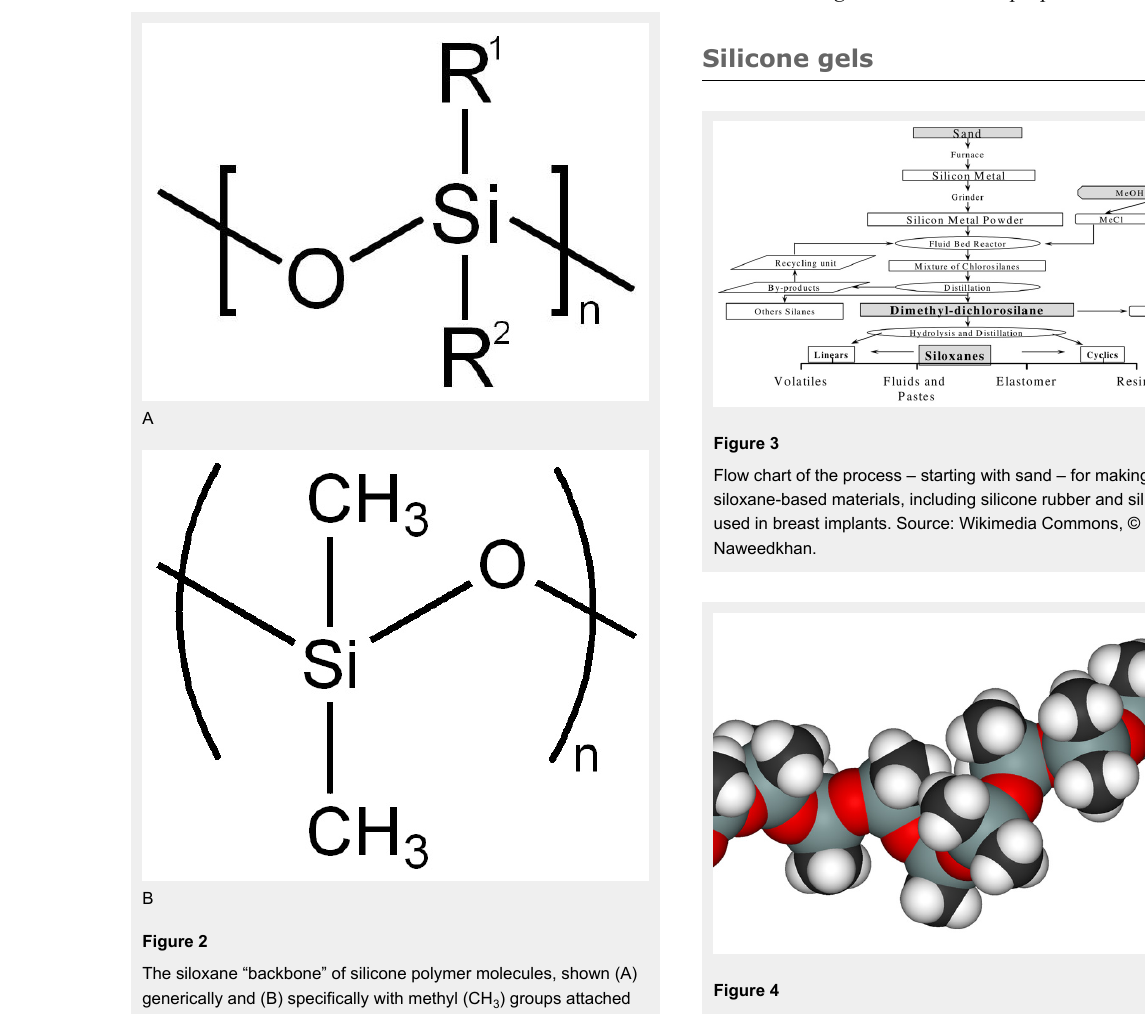
Three-dimensional representation of polydimethylsiloxane molecular structure. The large bond angles and bond lengths result in polymers which tend to be much more flexible and stretchable than rubbers with a carbon “backbone” – i.e. -C-C-C-. Source: Wikimedia